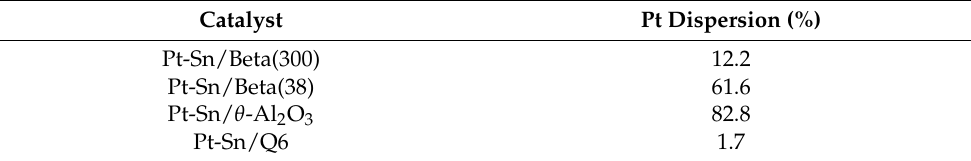
Figure 4. TEM images of supported Pt-Sn catalysts: ( a ) Pt-Sn/Beta(300), ( b ) Pt-Sn/Beta(38), ( c ) Pt-Sn/ θ -Al 2 O 3 , and ( d ) Pt-Sn/Q6. Table 3. Pt-dispersion of supported Pt-Sn catalysts estimated by CO